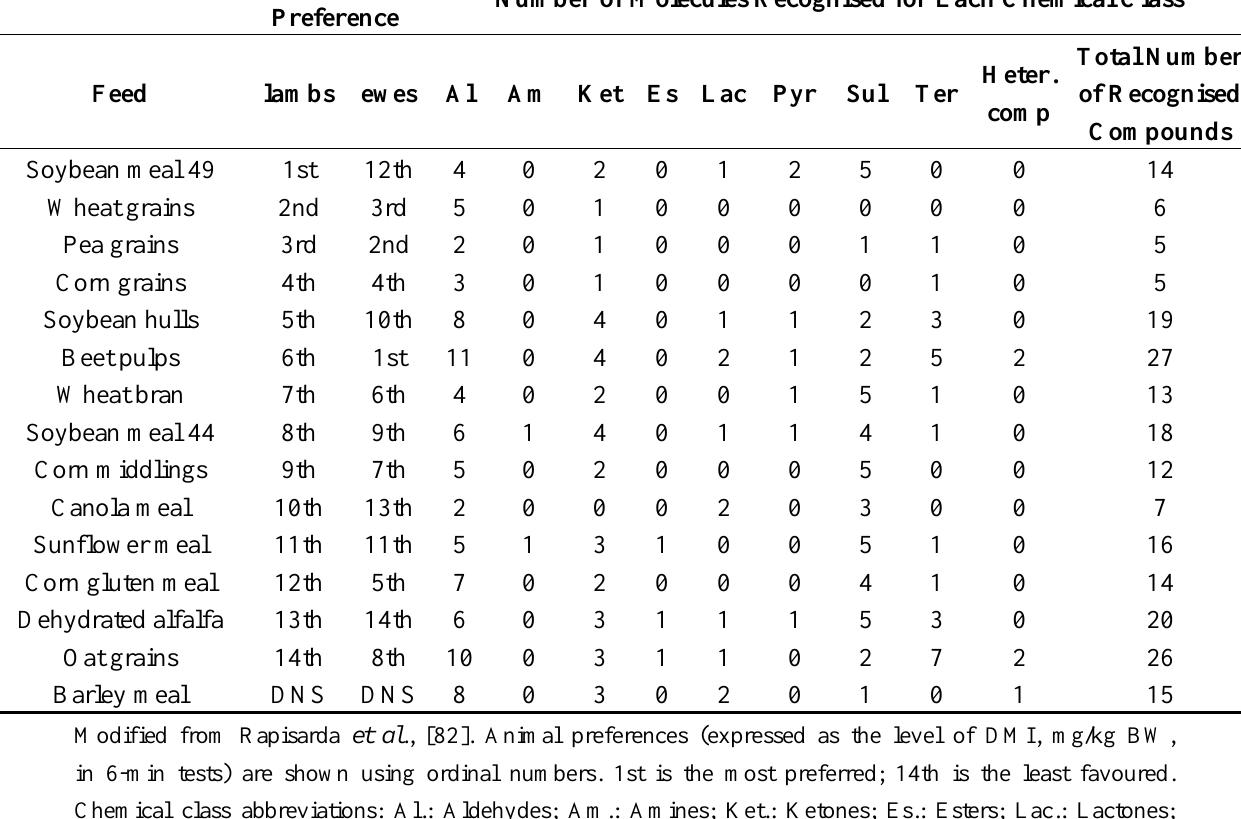
Table 3. Animal preferences for feed ingredients and the number of molecules detected for each chemical